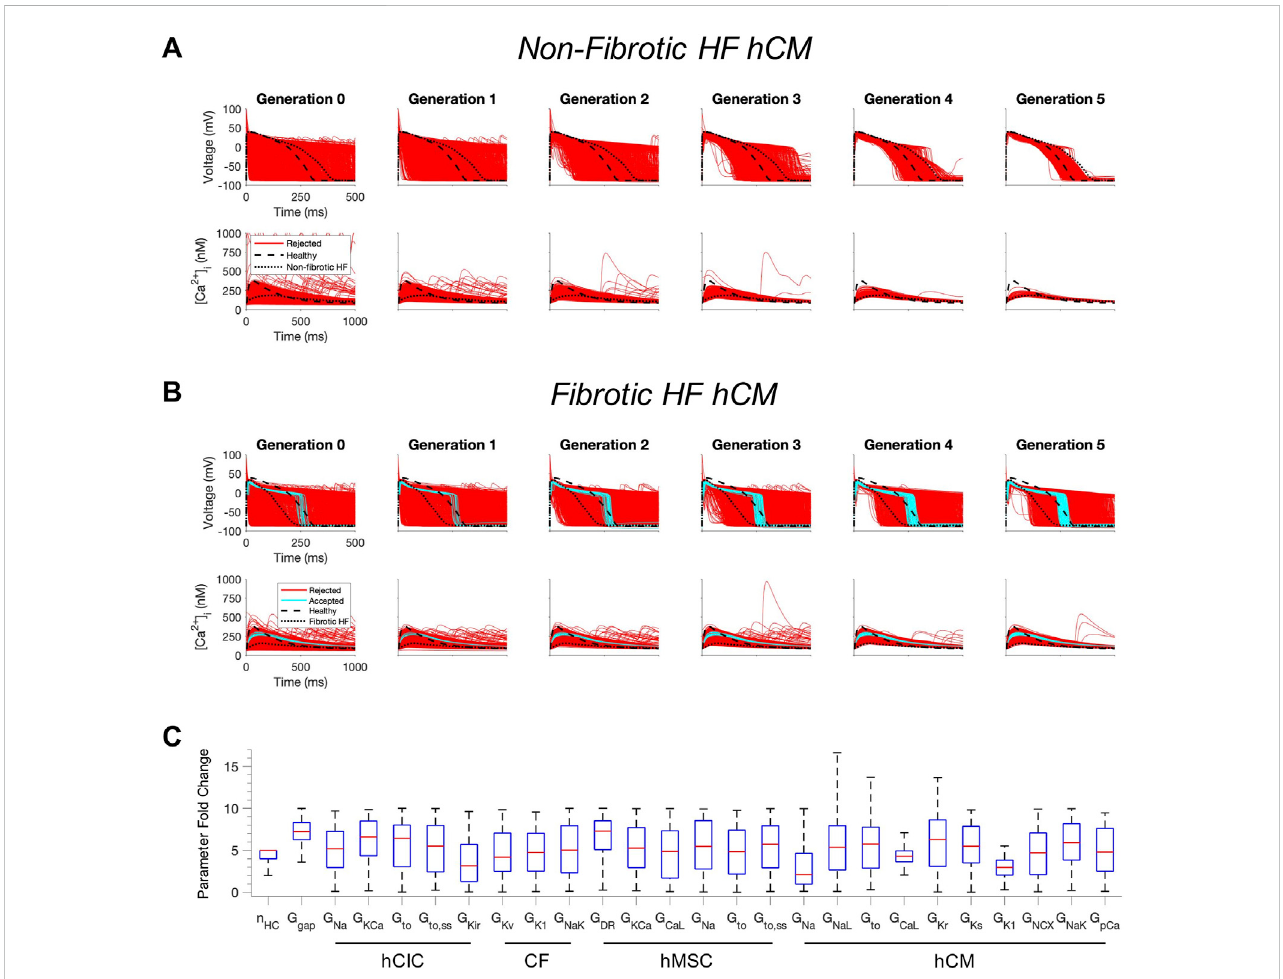
FIGURE 2 Custom cells expressing excitable cell channels restore a healthy phenotype in fi brotic failing cardiomyocytes. Initial populations of 2500 custom cell models were generated for heterocellular coupling with non- fi brotic (A) and fi brotic (B) heart failure (HF) human cardiomyocytes (hCMs) with pseudo- random perturbations of gap junction conductances, number of coupled cells, and both cardiomyocyte and non-excitable cell ion channel maximal conductivities. Custom cell populations underwent 5 generations of genetic algorithm evolution, whereby custom cells were accepted if root mean squareerrorwaslessthan50%forbothactionpotentialandcalciumtransientwaveforms(blue);modelsoutsidethisrangewererejected(red).Waveformsfor healthy and untreated HF cardiomyocytes are indicated by dashed and dotted lines, respectively. (C) Distribution of accepted custom cell model parameter fold changes (relative to baseline values) in the fi brotic HF condition shown as box and whisker plots. Note for certain parameters, a fold-change > 10 is achievedduetothegeneticalgorithmmutationstep.Abbreviations:hMSCs,humanmesenchymalstemcells;hCIC,c-kit + cardiacinterstitialcells;CF,cardiac fi broblast; hCM, human cardiomyocyte; n HC , Number of heterocellularly coupled cells; G gap , Gap junction conductance; G Na , Na + channel conductance; G KCa , Large-conductance Ca 2+ -activated K + channel conductance; G to , Transient outward K + channel conductance; G to,ss , Transient outward K + channel steady-state conductance;G Kir , Inward rectifyingK + channel conductance;G Kv , Time- and voltage-dependentK + channel conductance; G K1 , Inward recti fi er K + channel conductance; G NaK , Na + /K + pump activity; G DR , Delayed recti fi er K + channel conductance; G CaL , L-type Ca 2+ channel conductance; G NaL , Na + channel conductance,late component; G Kr , Rapid delayedrecti fi er K + channel conductance;G Ks , Slowdelayedrecti fi er K + channel conductance; G NCX , Na + / Ca 2+ exchanger conductance; G pCa Sarcolemmal Ca 2+ pump